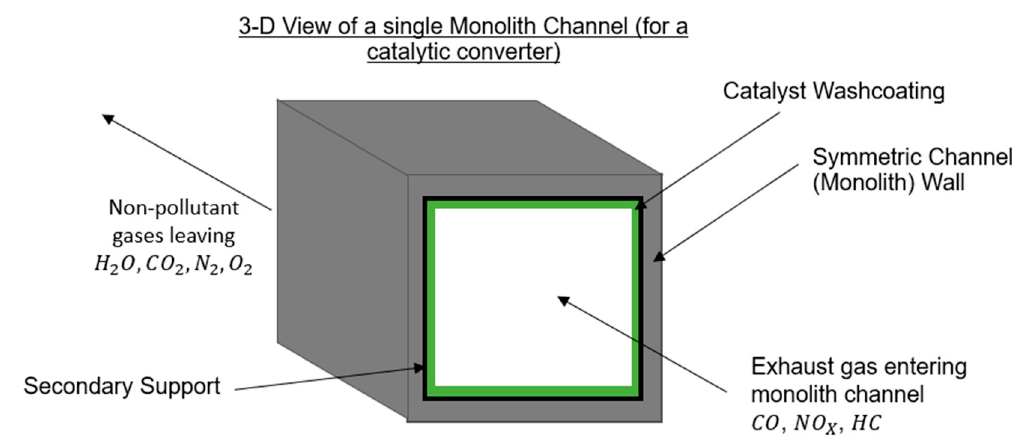
Figure 2. Reactants passing through a single monolith channel and exiting as products. Monolith wall = solid grey colour, secondary support = black and catalyst layer = green. Adapted from [34,35].